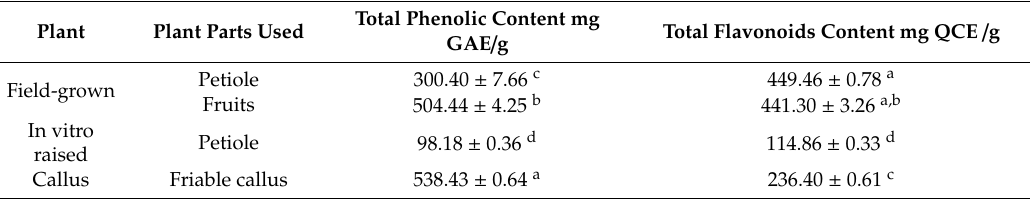
Table 7. Total flavonoids and phenolics content of the field-grown plant parts, in vitro propagated and in vitro-derived